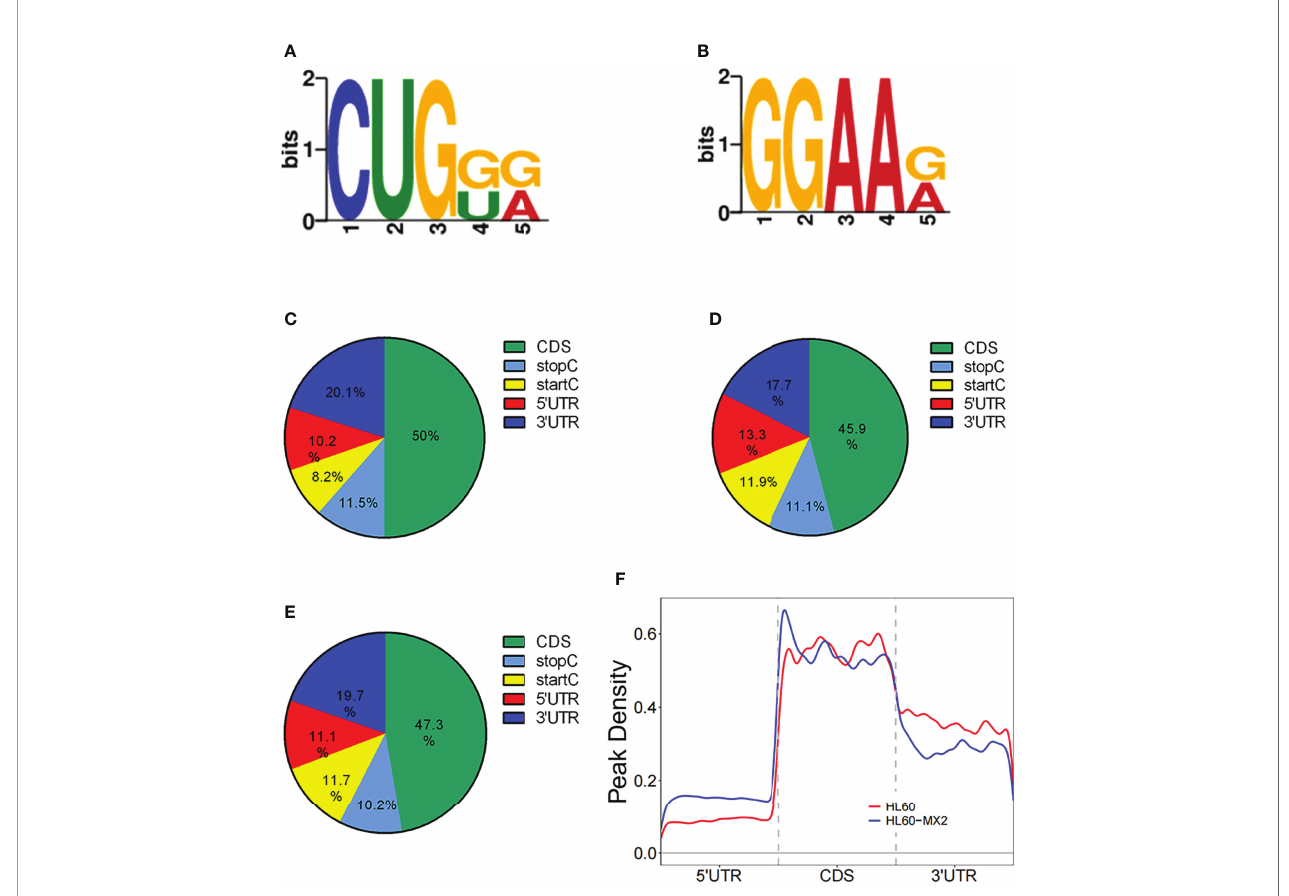
FIGURE 2 | Motif and regional analysis of m7G methylation. (A) Motif with minimum E-value of m7G in HL-60 cells. (B) Motif with minimum E-value of m7G in HL60/ MX2 cells. (C) Pie chart of m7G peaks in different regions of mRNA in HL-60 cells. (D) Pie chart of m7G peaks in different regions of mRNA in HL60/MX2 cells. (E) Pie chart of m7G peaks in different regions of mRNA in differentially modi fi ed genes of the two groups. (F) Analysis of the peak density modi fi ed by m7G methylation.